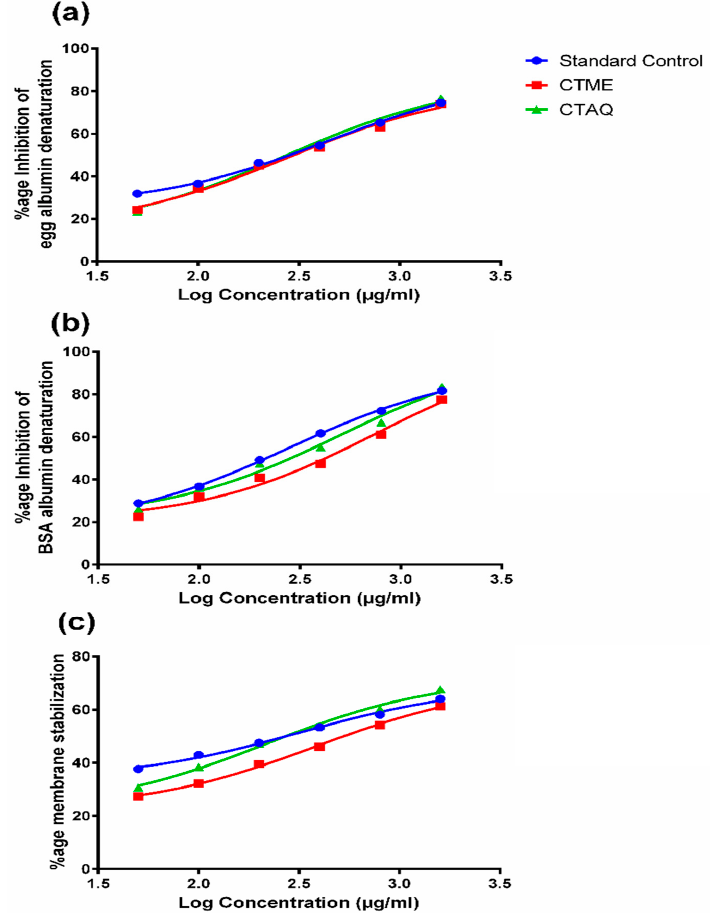
Figure 3. Caralluma tuberculata extracts on inhibition of protein denaturation and membrane stabi- lization. ( a ): Egg albumin denaturation assay; ( b ): BSA denaturation assay; ( c ): HRBC membrane sta- bilization assay.